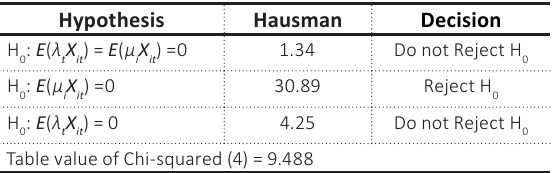
Table 8. Hausman test for two-way model results Hypothesis Hausman Decision